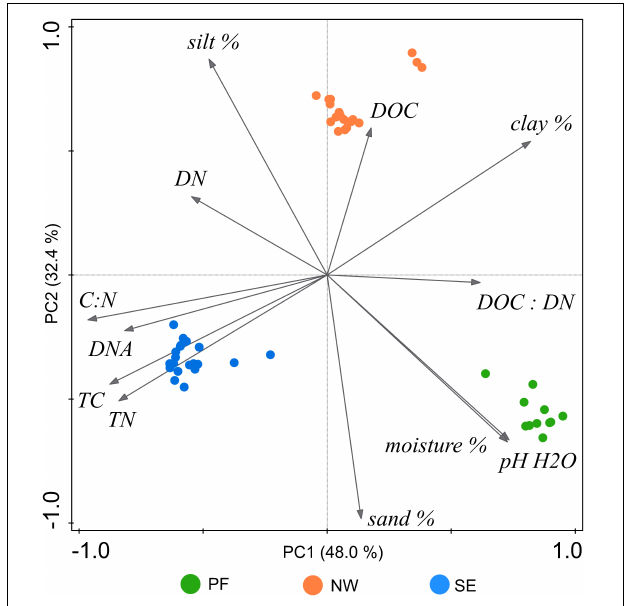
FIGURE 1 | Unconstrained PCA ordination of characteristics (at the time of incubation) of soils from the three investigated origins on “Muot-da-Barba-Peider” in the eastern Swiss Alps. DNA, DNA content; DOC, dissolved organic carbon; DN, dissolved nitrogen; TC, total soil organic carbon; TN, total soil nitrogen; pH H 2 O, pH in water extract; moisture %, gravimetric soil moisture; sand, silt, and clay %, percentage of each soil texture components.